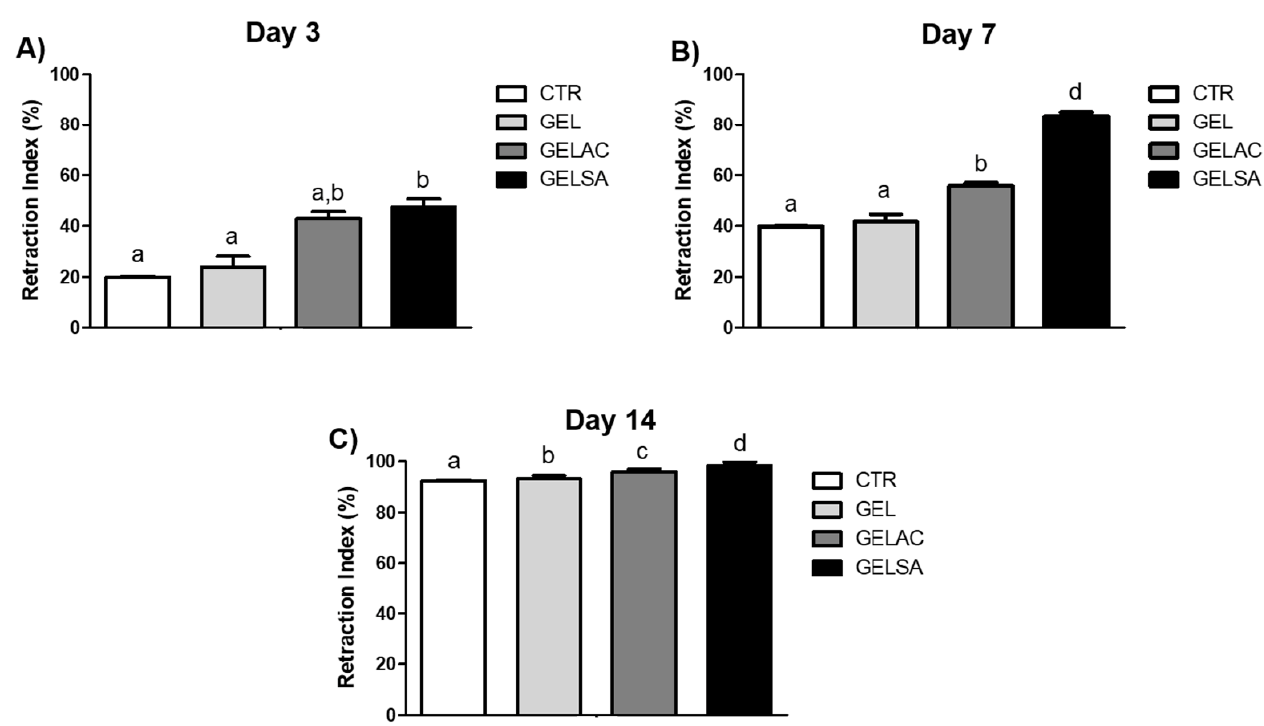
Figure 10. Determination of the average wound retraction indices of the experimental animals on day 3 ( A ), day 7 ( B ), and day 14 ( C ). Data are expressed so that equal letters represent no significant difference and different letters represent a difference of p < 0.001.